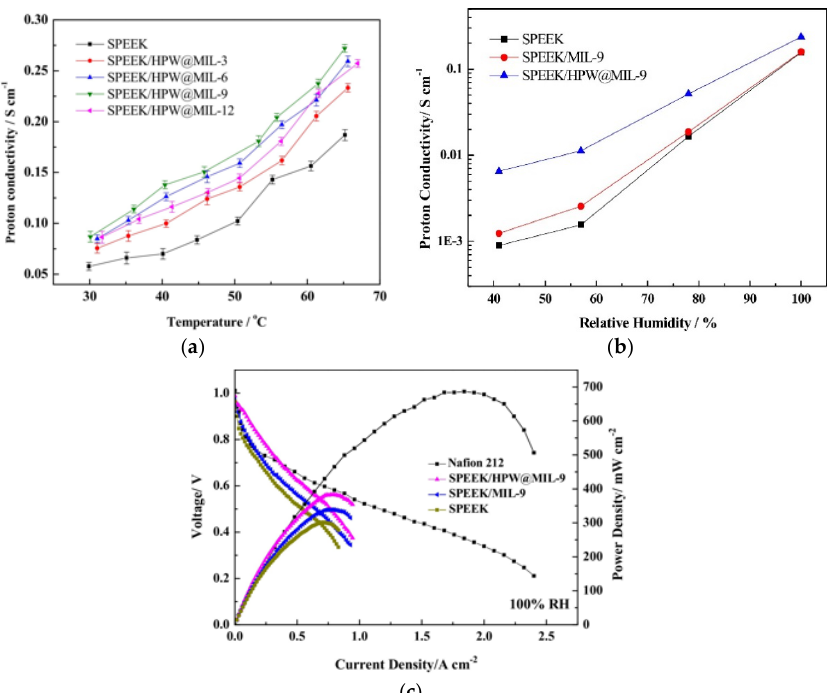
Figure 20. Proton conductivity of SPEEK/HPW@MIL101 membranes with different filler content at 100% RH under different temperatures ( a ); proton conductivity of the membranes with 9 wt.% RH under di ff erent temperatures ( a ); proton conductivity of the membranes with 9 wt.% HPW@MIL101 under di ff erent RHs ( b ); single H 2 / O 2 fuel cell performance ( c ). Reprinted with permissions from